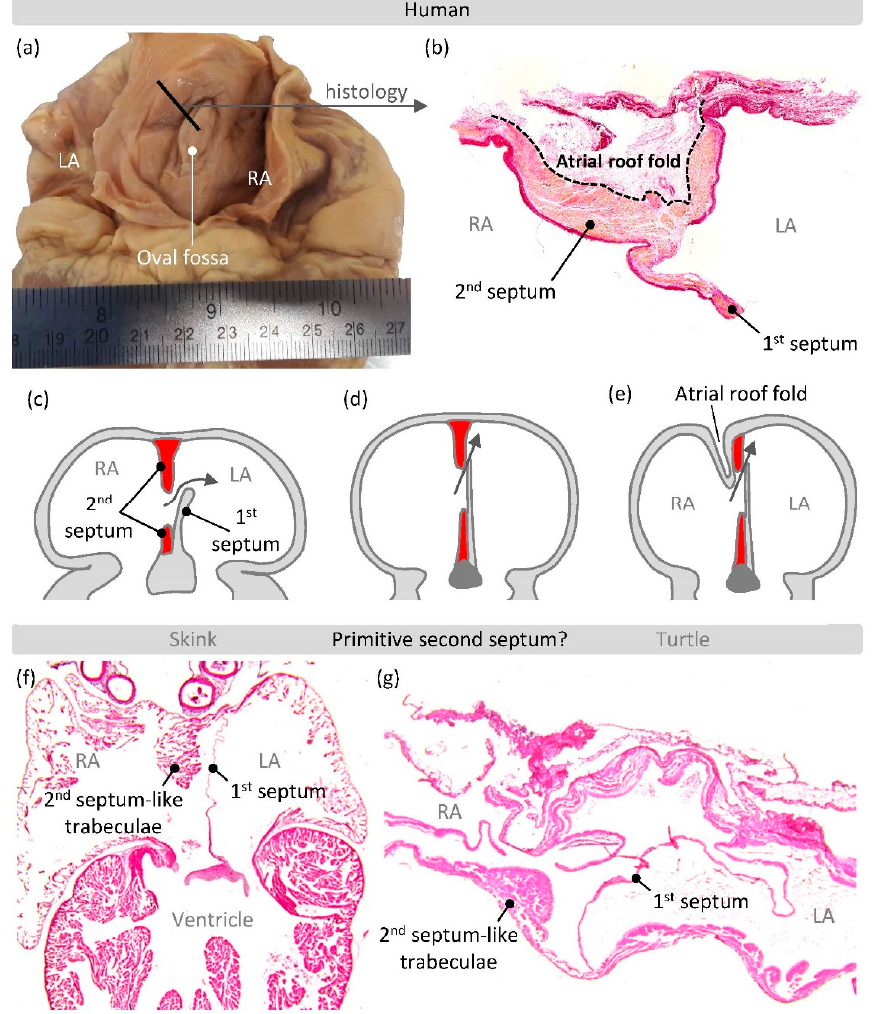
Figure 4. The atrial septum. ( a ) The atrial septum of the heart of an adult human exposed by a cut through the intercaval (sinus venarum) area. The thick black line indicates the part of the posterior-superior part of the septum that was sectioned with histology. ( b ) Histology showing the fold in the atrial roof (a very similar setting has been demonstrated in pig, for example [102,103]). ( c , d ) Schematic representations of the atrial septum of perinatal stages, with the secondary septum in red. Notice that the fold in the atrial roof is not cartooned. Adapted from [104,105]. ( e ) Example of schematic that makes a compromise between fold and septum, adapted from [106]. ( f , g ) Histology of reptiles showing a secondary septum-like aggregate of trabecular muscle in the right atrium of a skink (( f ) horizontal section) and a turtle (( g ) transverse section), adapted from [107].